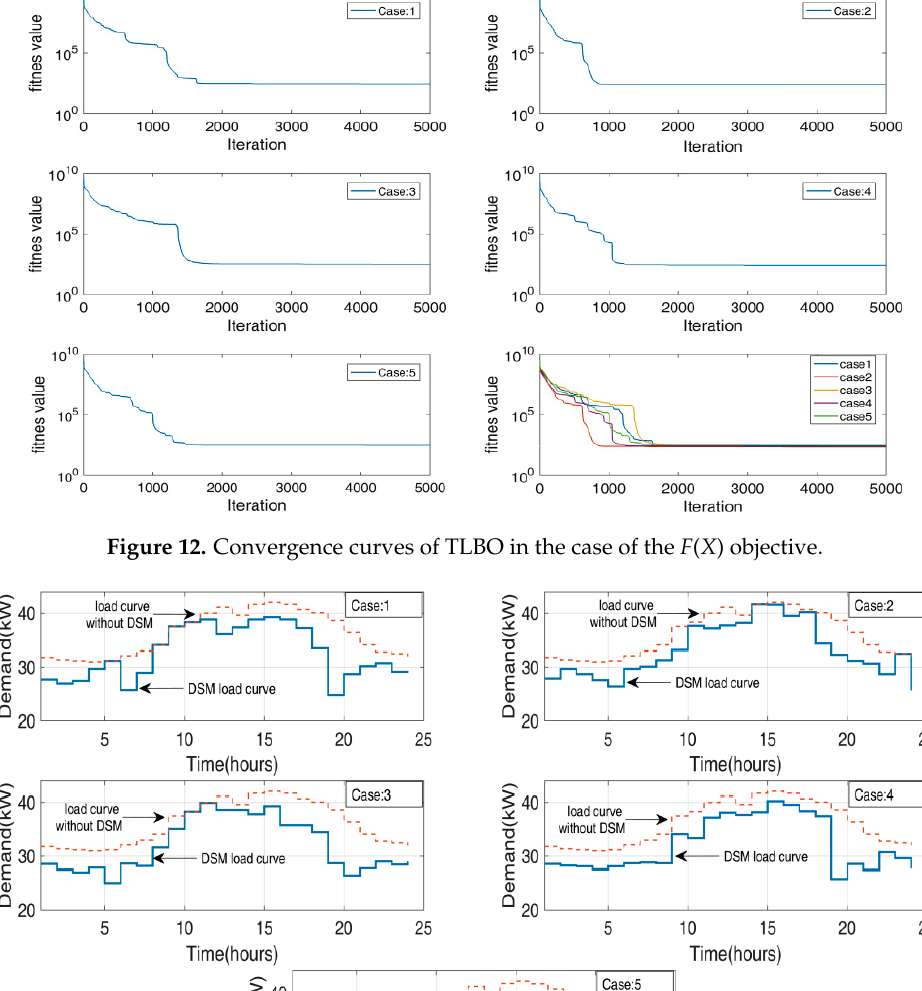
Figure 12. Convergence curves of TLBO in the case of the F ( X ) objective. Table 3. Load curve data for DSM cases1–5.